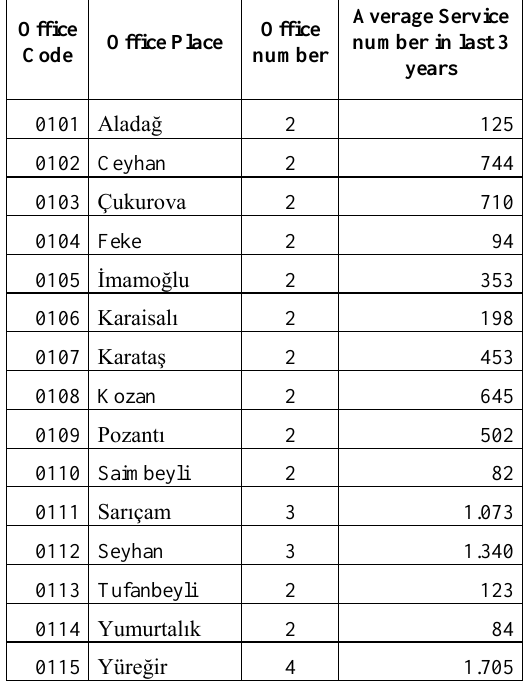
Table 2. LOSC numbers which are planned by GDLRC. (TKGM, 2016b; Examination Guide, 2013.)